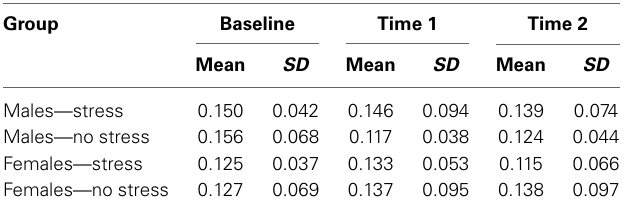
Table 1 | Cortisol levels (in μ g/dL, mean and standard deviation) for males and females in the stress and no stress groups.